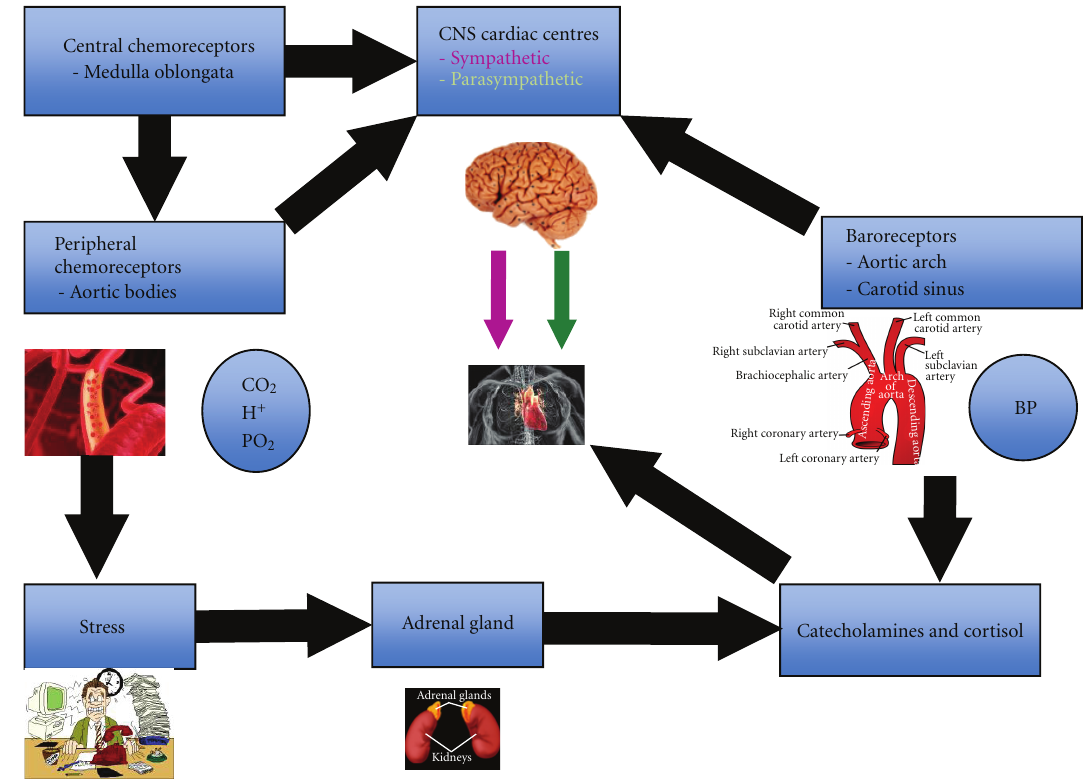
Figure 1: Pathophysiology of fetal heart rate changes. Table 1: Categorizing individual features of CTG according to NICE